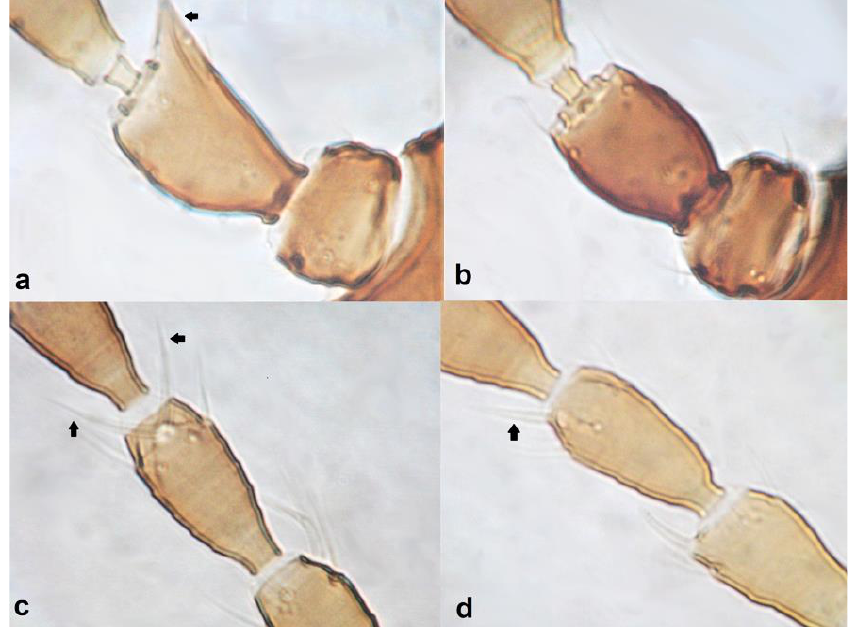
Figure 23. Antennal segment II ( a , b ): ( a ) asymmetrical; ( b ) symmetrical; antennal segments III and IV ( c , d ): ( c ) with forked sense cones; ( d ) with simple sense cones.